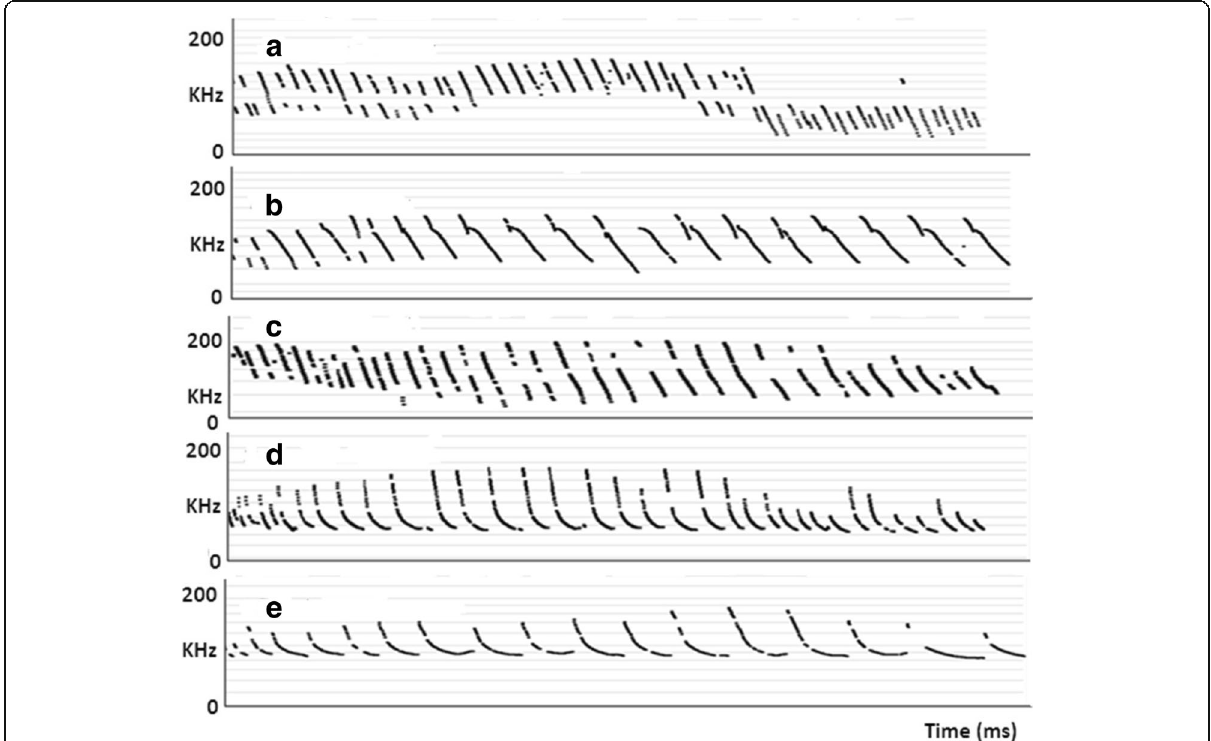
Fig. 1 Sonograms of echolocation calls of Chaerephon major ( a ), Mops condylurus ( b ), Mops niveiventer ( c ), Scotophilus dinganii ( d ), and Scotophihus leucogaster ( e